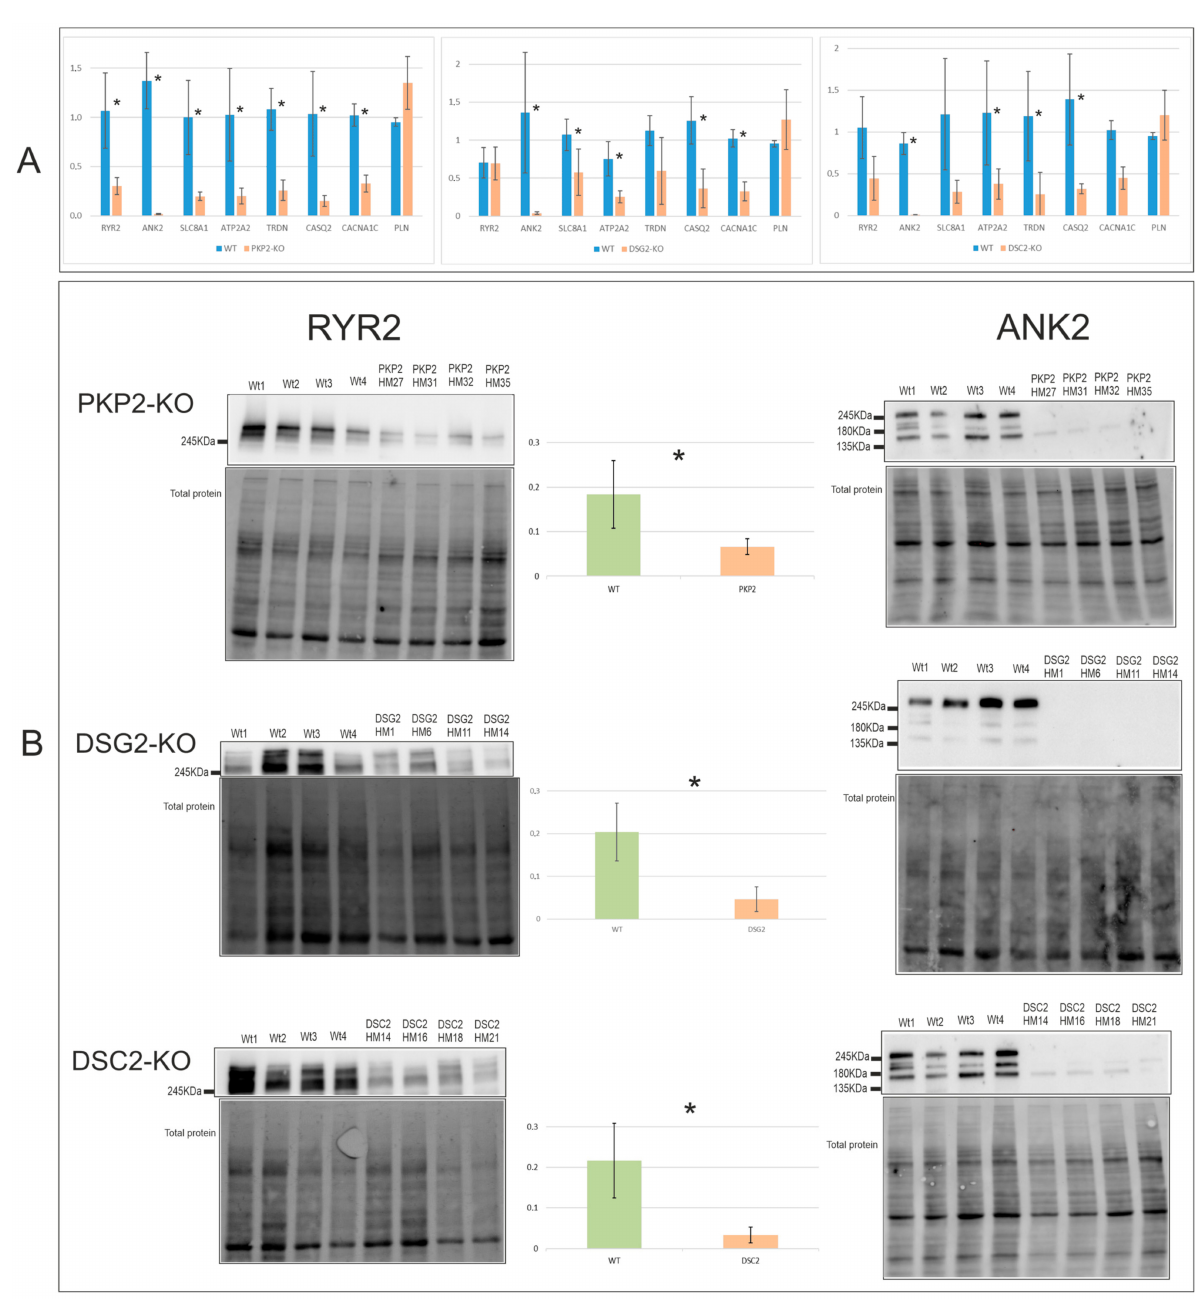
Figure 2. Calcium cycle gene expression at the mRNA ( A ) and protein ( B ) levels. * Indicates the gene expression levels that were significantly different between WT and edited clones; p -value <0.05, see Table S4. Number of experiments: RT-PCR = 1; WB =